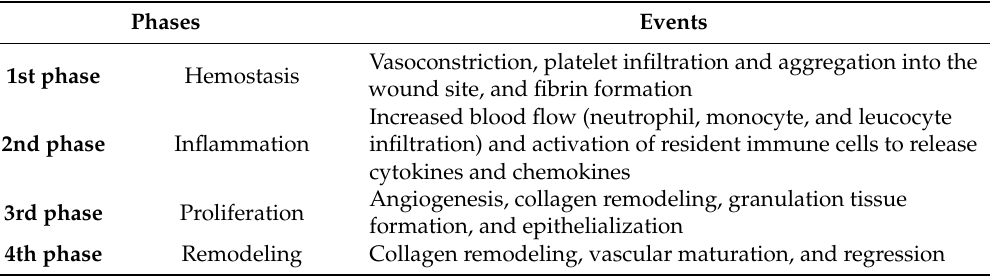
Table 2. The process of normal wound